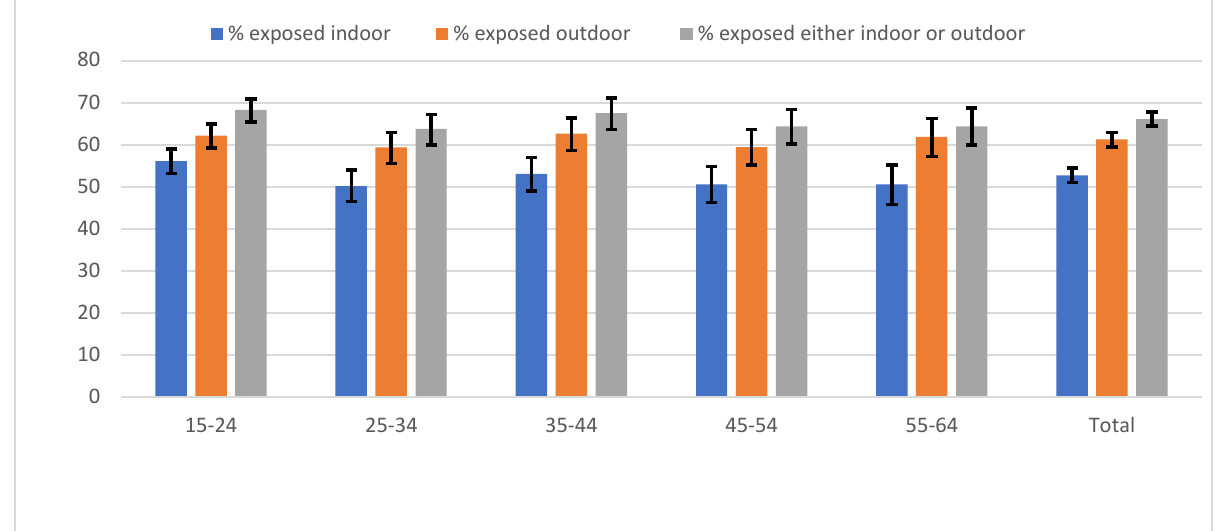
Figure 1. Exposure to second-hand smoke by age. N.B.: The vertical lines on top of the bars represent the 95% Confidence Intervals.